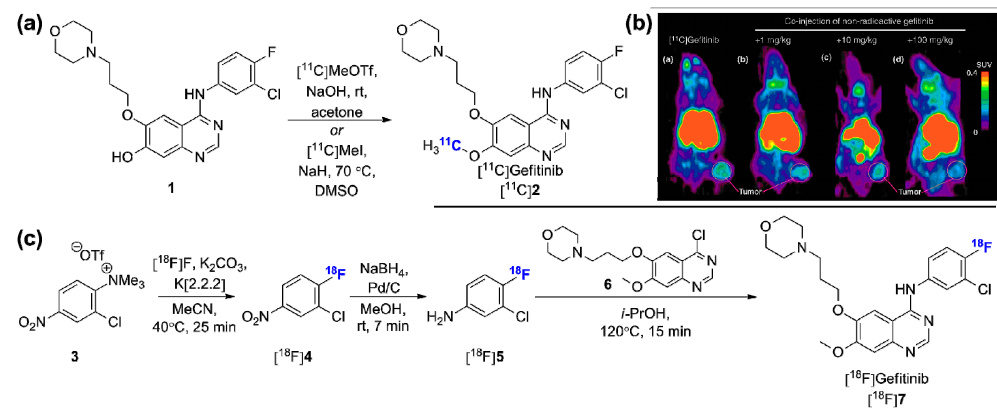
Figure 2. Radiolabeled gefitinib. ( a ) Alternative conditions for the radiosynthesis of [ 11 C]gefitinib; ( b ) In vivo PET evaluation (coronal images) of [ 11 C]gefitinib in tumor-bearing (NFSa) mice at baseline ( a ) and with increasing non-radioactive gefitinib ( b – d ) (adapted with kind permission from